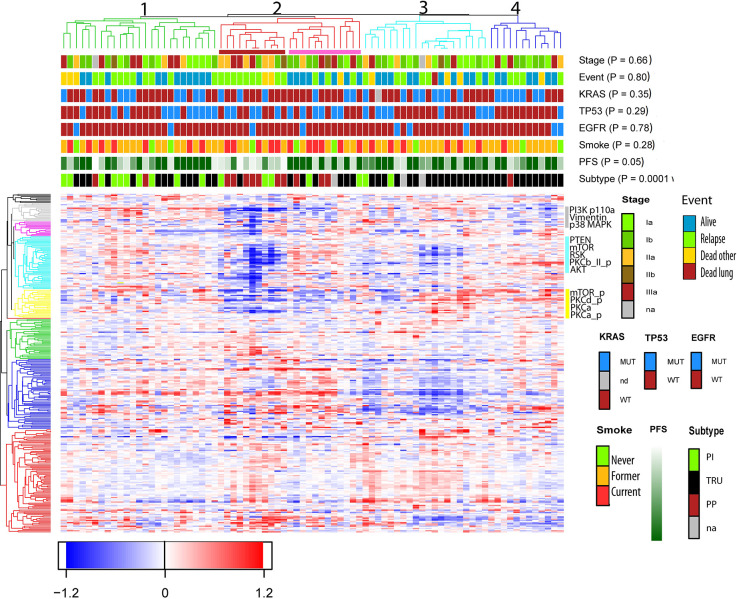
Unsupervised hierarchical cluster analysis based on protein expression from 80 non-small cell lung cancer (NSCLC) samples. Clinical variables such as smoking status, mutations status of the gene TP53, KRAS, and EGFR, RFS (ranging from 1 month = light green to dark green = 60 months) and event, were included to see if these features were enriched within the clusters. Events were divided into four categories; no event, relapse (which also includes metastasis), dead of lung cancer and dead of other reasons. The samples clustered into four subclusters marked with green, red, turquoise, and blue branches. Beneath subcluster two (red branch) a red box indicates a smaller cluster named 2a, and a pink box is drawn beneath subcluster 2b, 2c, and 2d. Subcluster 2a is recognized with poor RFS and enriched with subtype PP. The proteins are clustered into nine subclusters seen on the left side. The proteins PKCα, PKCα_p, and PKCδ_p belongs to the yellow cluster, and PKCβ-II_p is shown in the turquoise cluster.